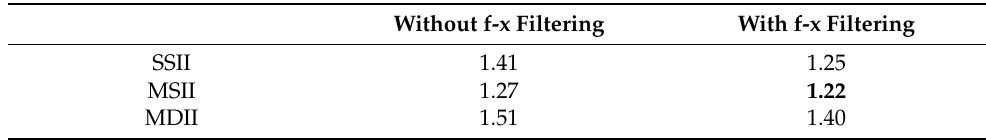
Table 2. The RMSE of the inversion results (blind well) of SSII, MSII and MDII combined with and without f-x